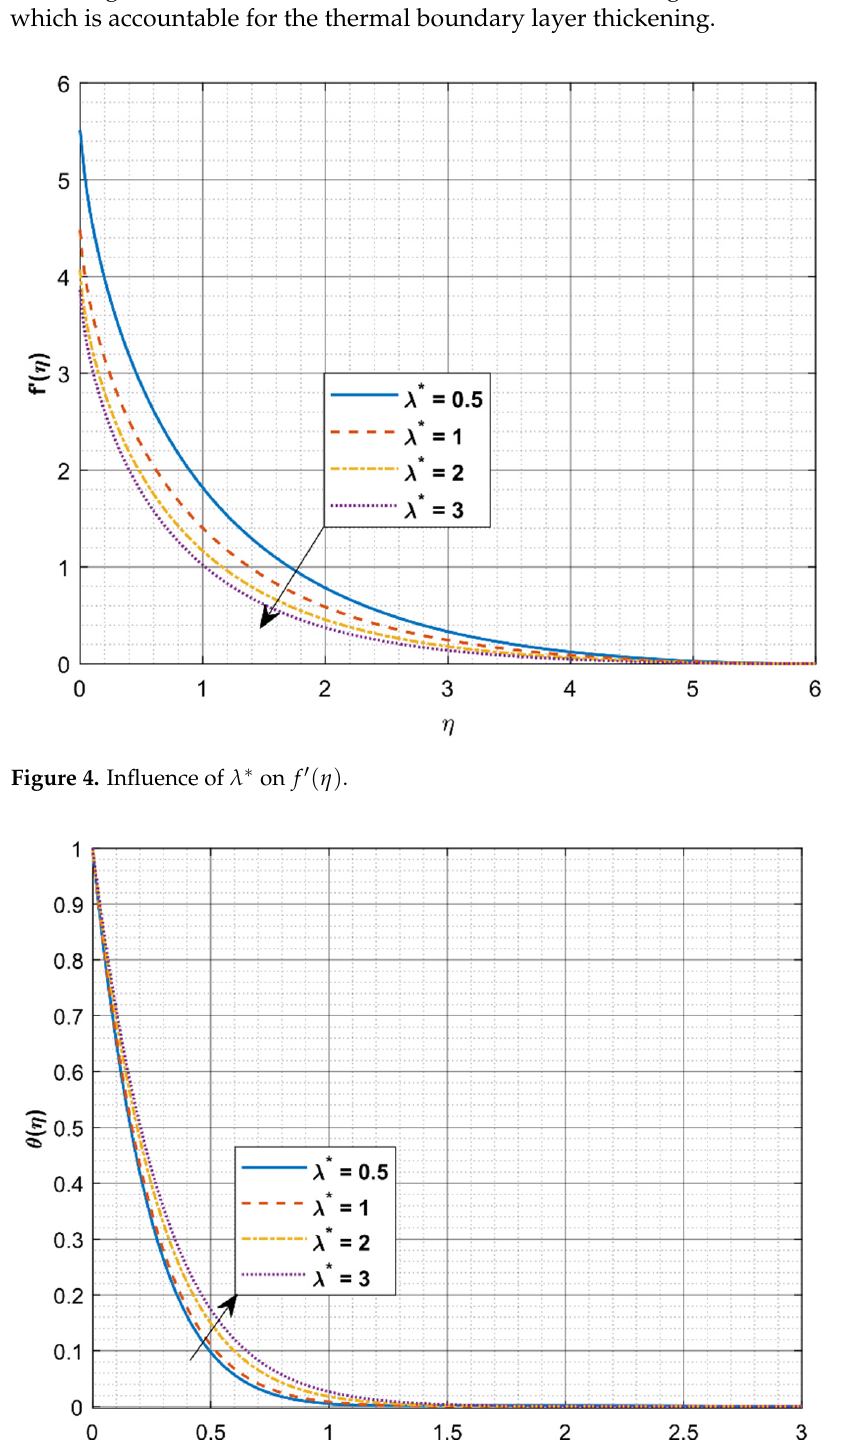
fluid motion along the surface, the λ ∗ reflects resistance to movement with an increase in thermal gradient. This is in line with the fact that increasing λ ∗ adds some extra tension which is accountable for the thermal boundary layer thickening.